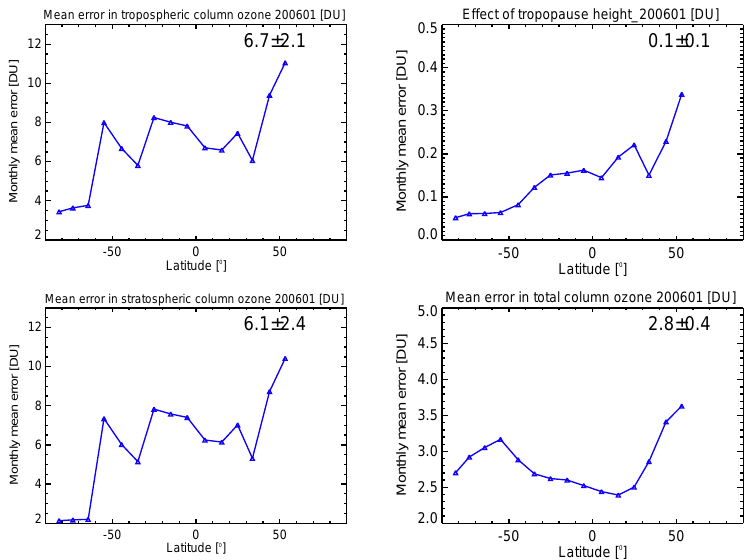
Figure 3. Top panels from left to right: monthly mean zonal mean error in tropospheric ozone columns (TOCs) and contribution from errors in tropopause height for January 2006. Bottom panels from left to right: monthly mean zonal mean error of stratospheric ozone column (SOC) and total ozone (TOZ) in January 2006, contributing to the error in tropospheric ozone columns (TOC).